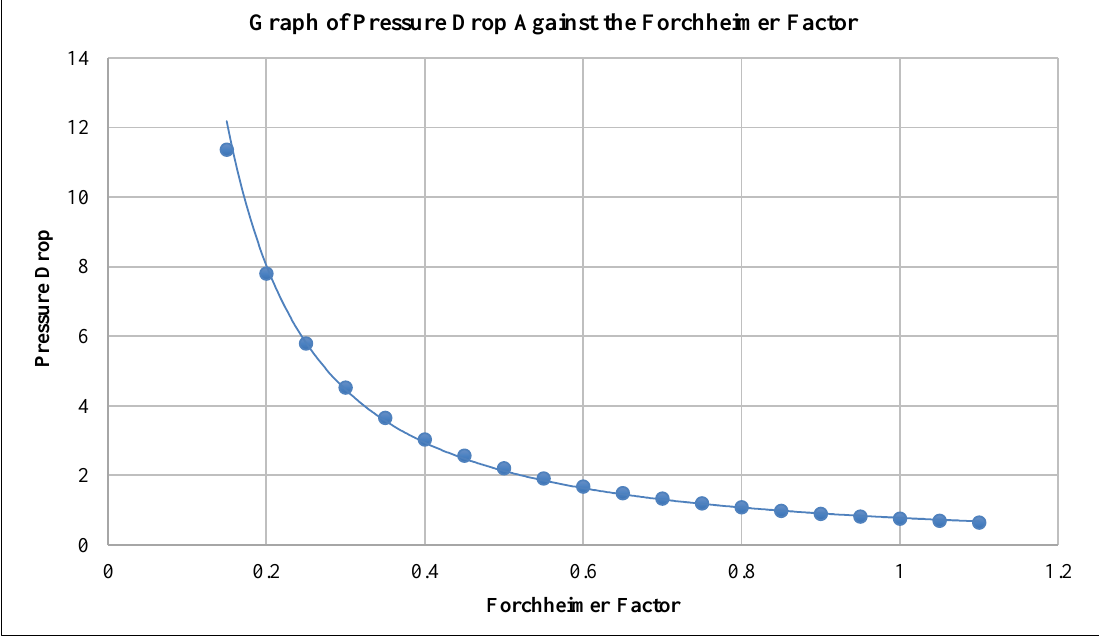
Figure 3. Effect of the Forchheimer Factor on Pressure Drop in a